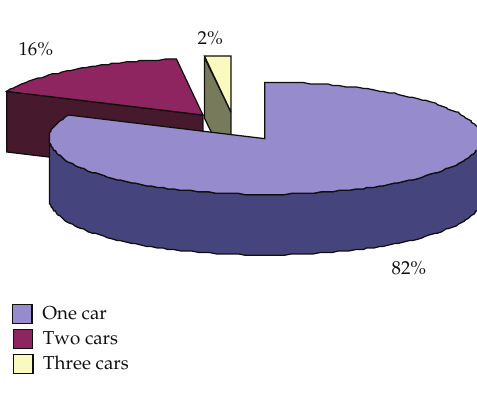
Figure 1: Car ownership distribution.